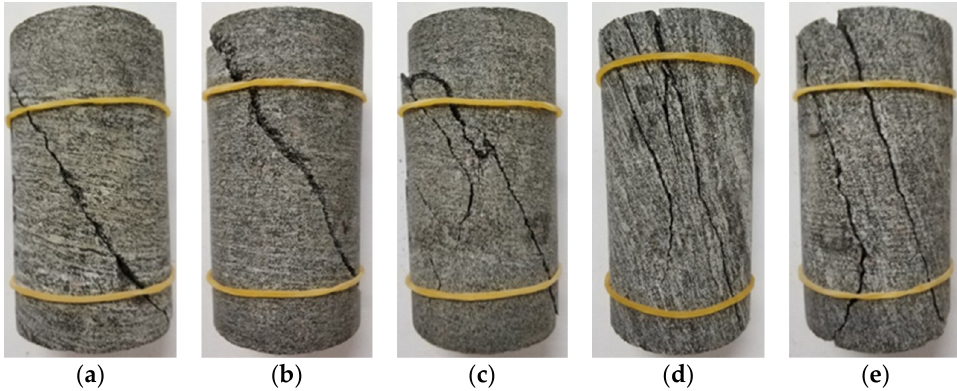
Figure 10. Failure modes of gneiss in the conventional geostress area. ( a ) 5 MPa. ( b ) 10 MPa. ( c ) 15 MPa. ( d ) 20 MPa. ( e ) 25 MPa. ( d ) 20 MPa. ( e ) 25